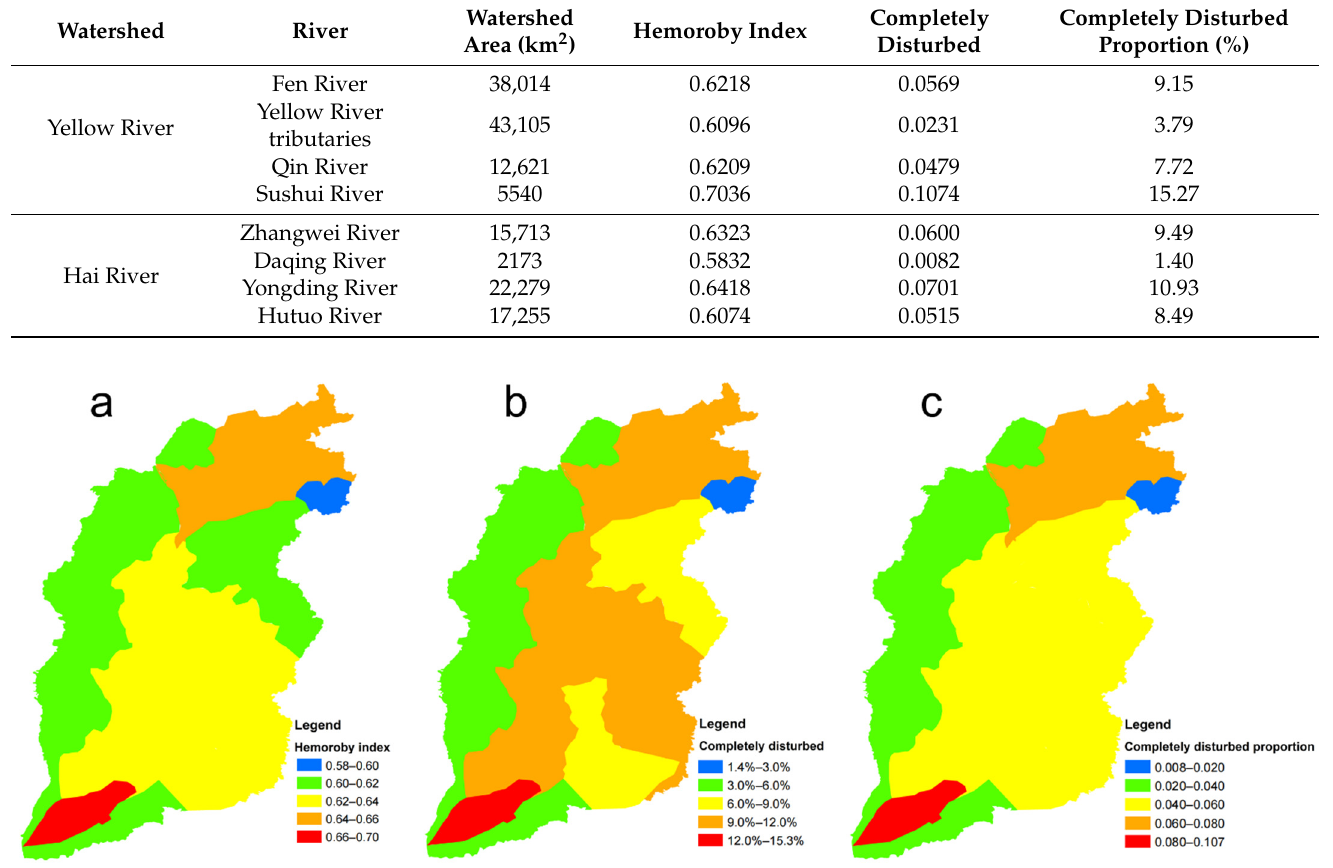
Table 2. Anthropogenic interference levels, including Hemoroby index, completely disturbed, and completely disturbed proportion in different watersheds and rivers.